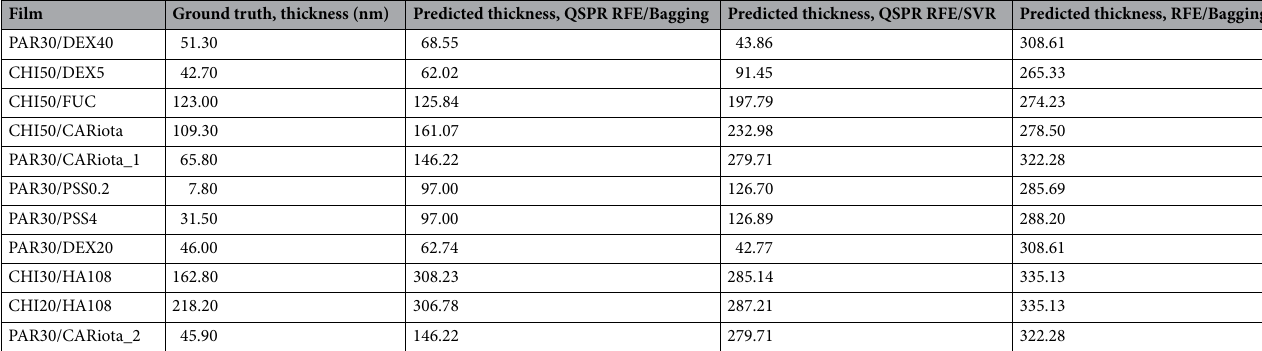
Table 2. The thickness of the coatings predicted with three models and thickness determined experimentally (ground truth).